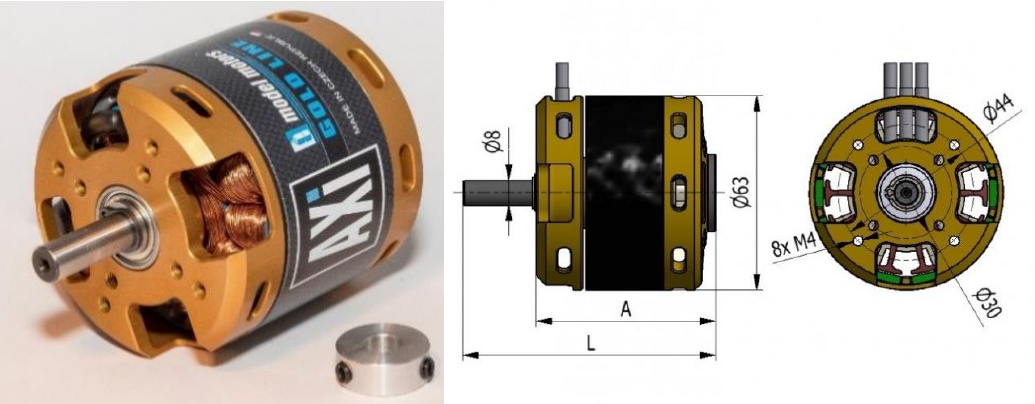
Figure 2. AXI 5320/18 GOLD LINE V2 [22].